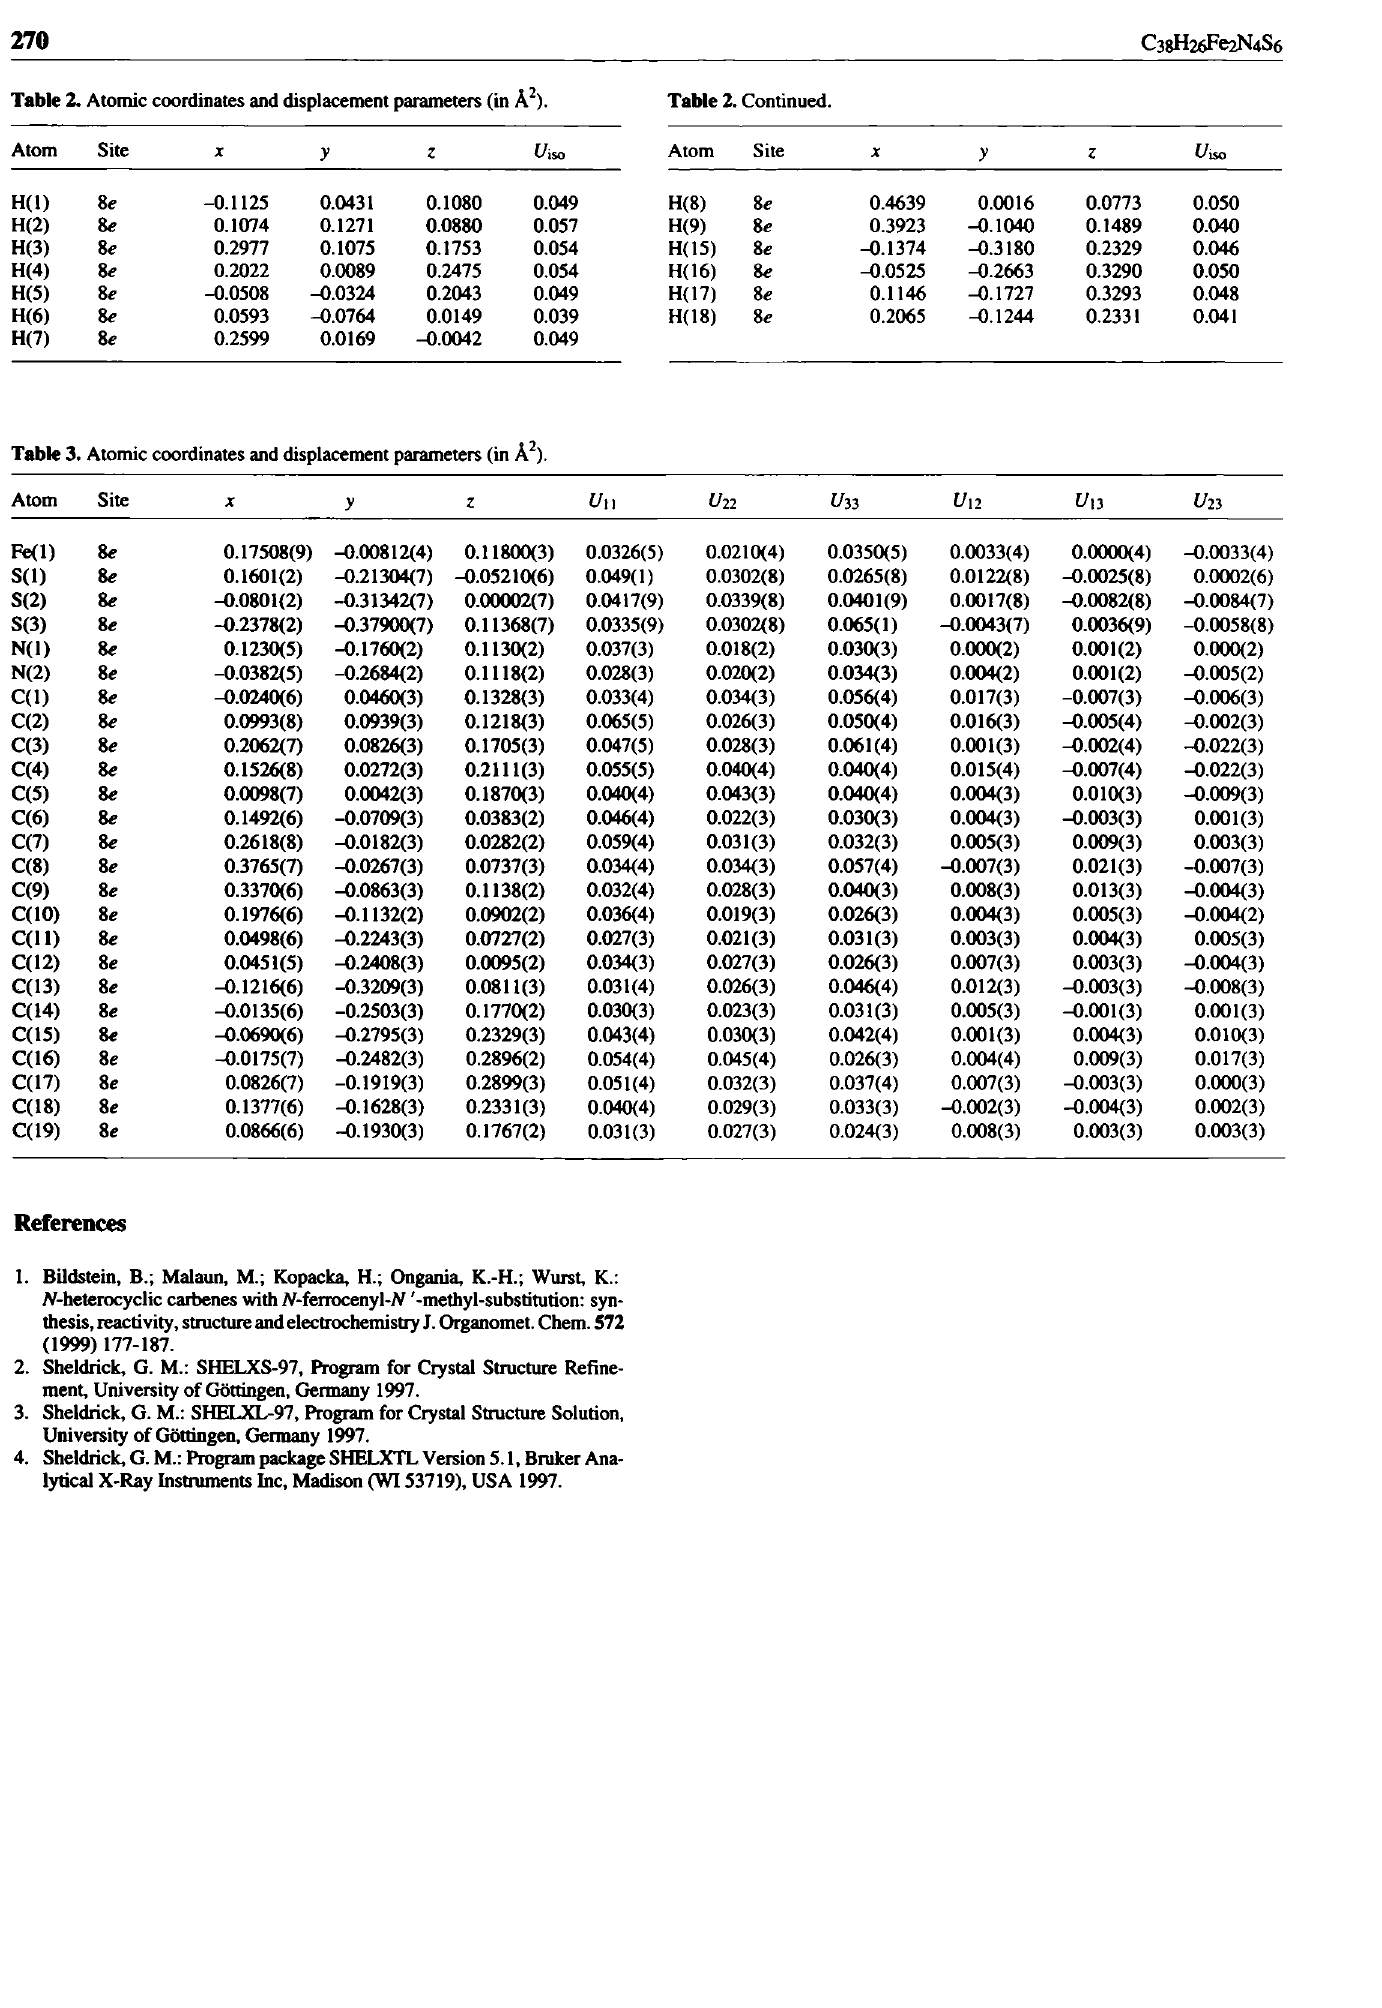
Table 3. Atomic coordinates and displacement parameters (in Â 2